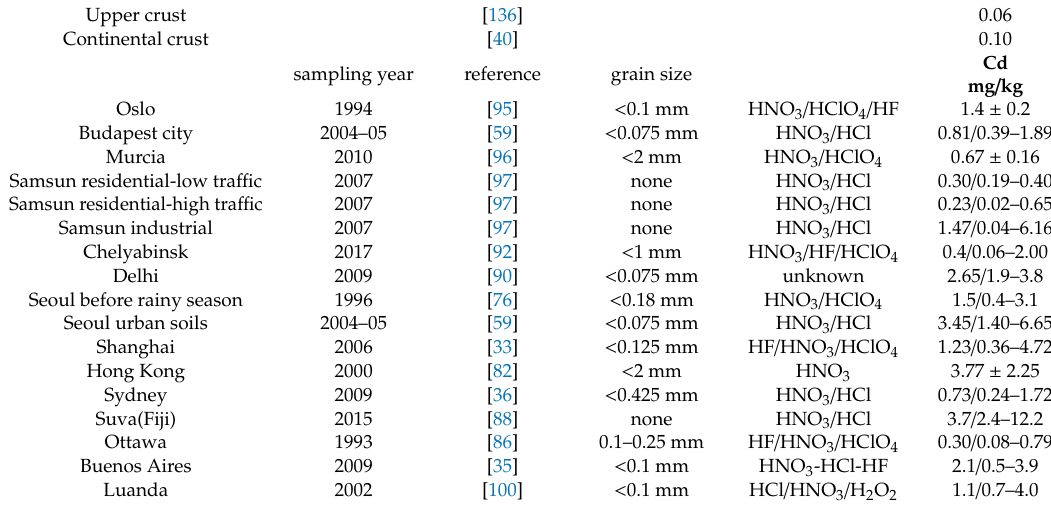
Table A26. Cadmium in road dust.